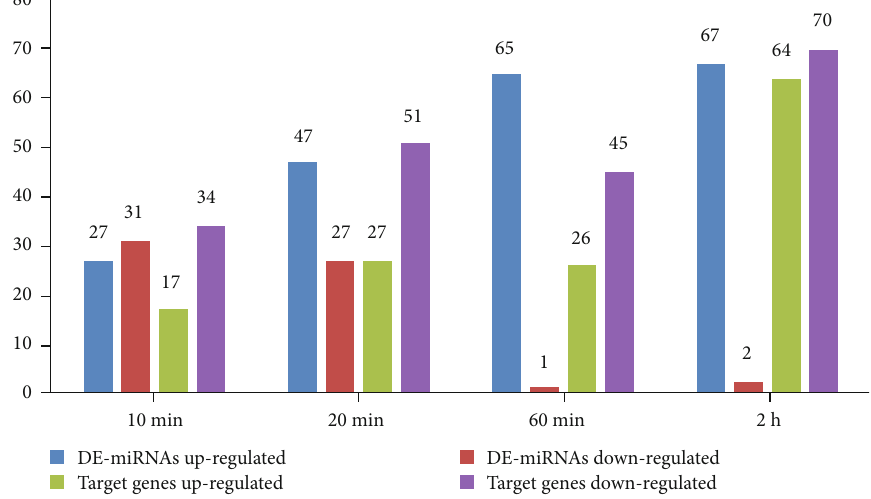
Figure 3: Numbers of high-con fi dence target genes and their DE-miRNAs at the time points of 10min, 20min, 60min, and 2h after the heat treatment. The horizontal axis represents the time after the heat treatment, and the vertical axis represents the number of up- and downregulated